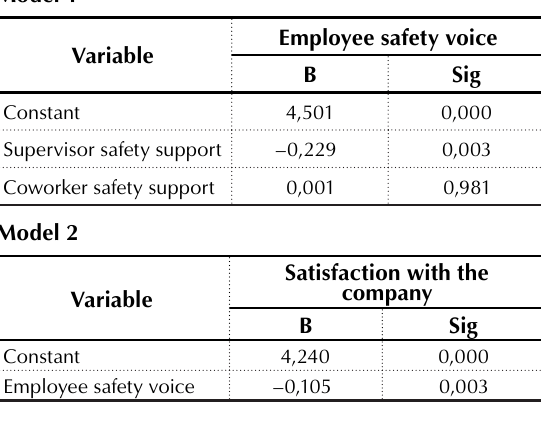
Table 2. Result of multiple regression